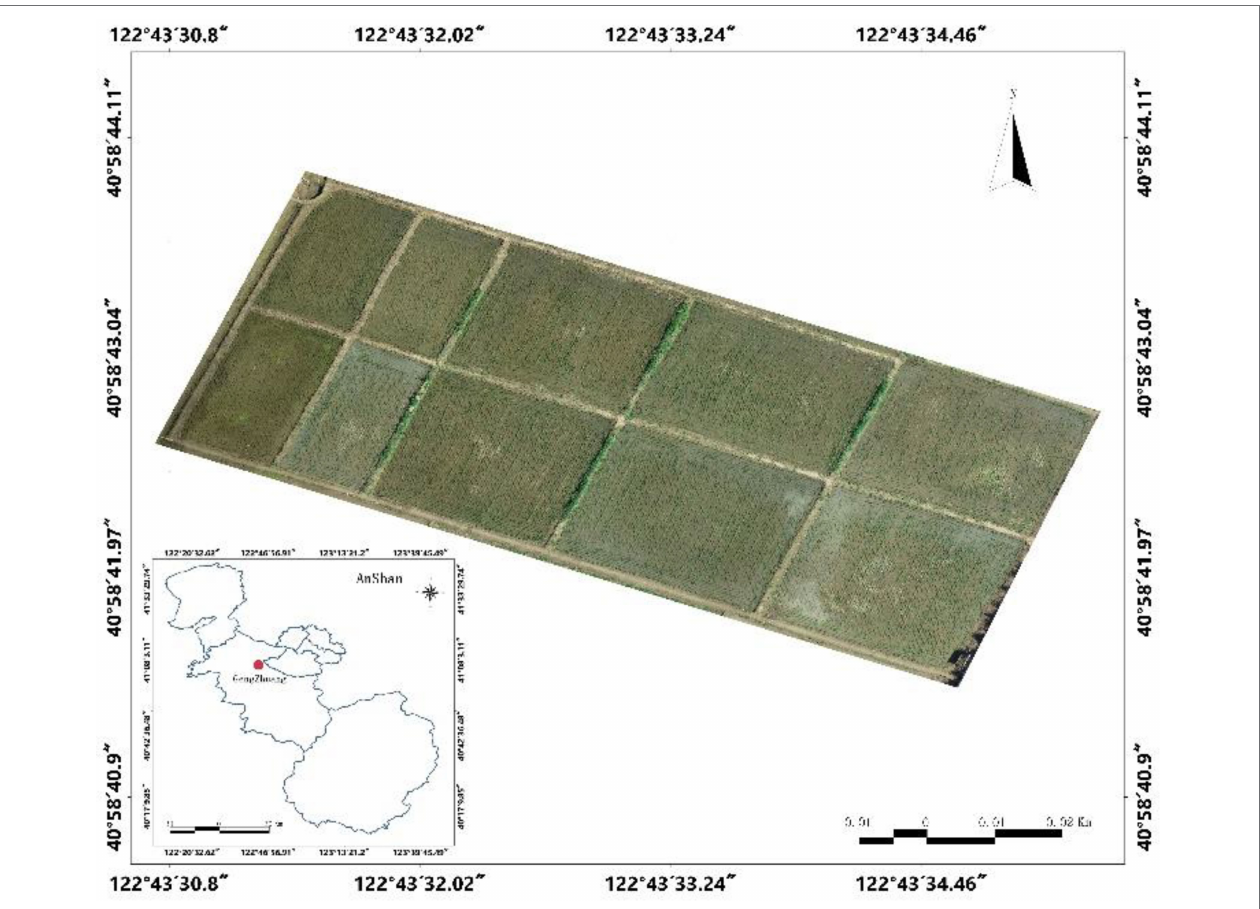
FIGURE 1 | Study area.